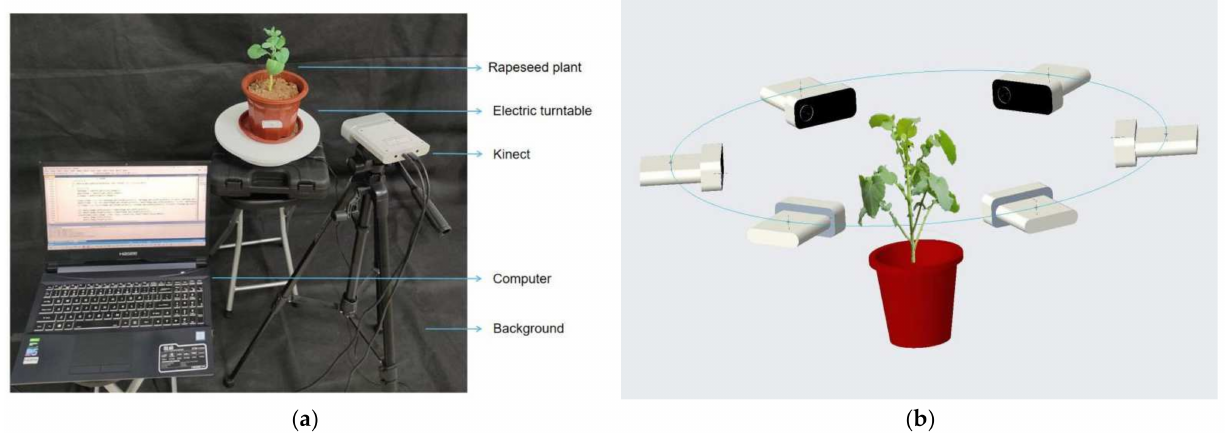
Figure 1. Rape plant image collection. ( a ) Image acquisition platform. ( b ) Collection